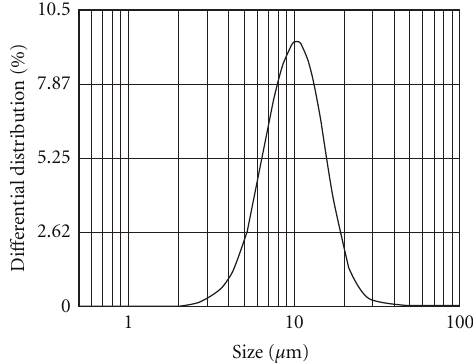
Figure 2: Size distribution of microparticle.